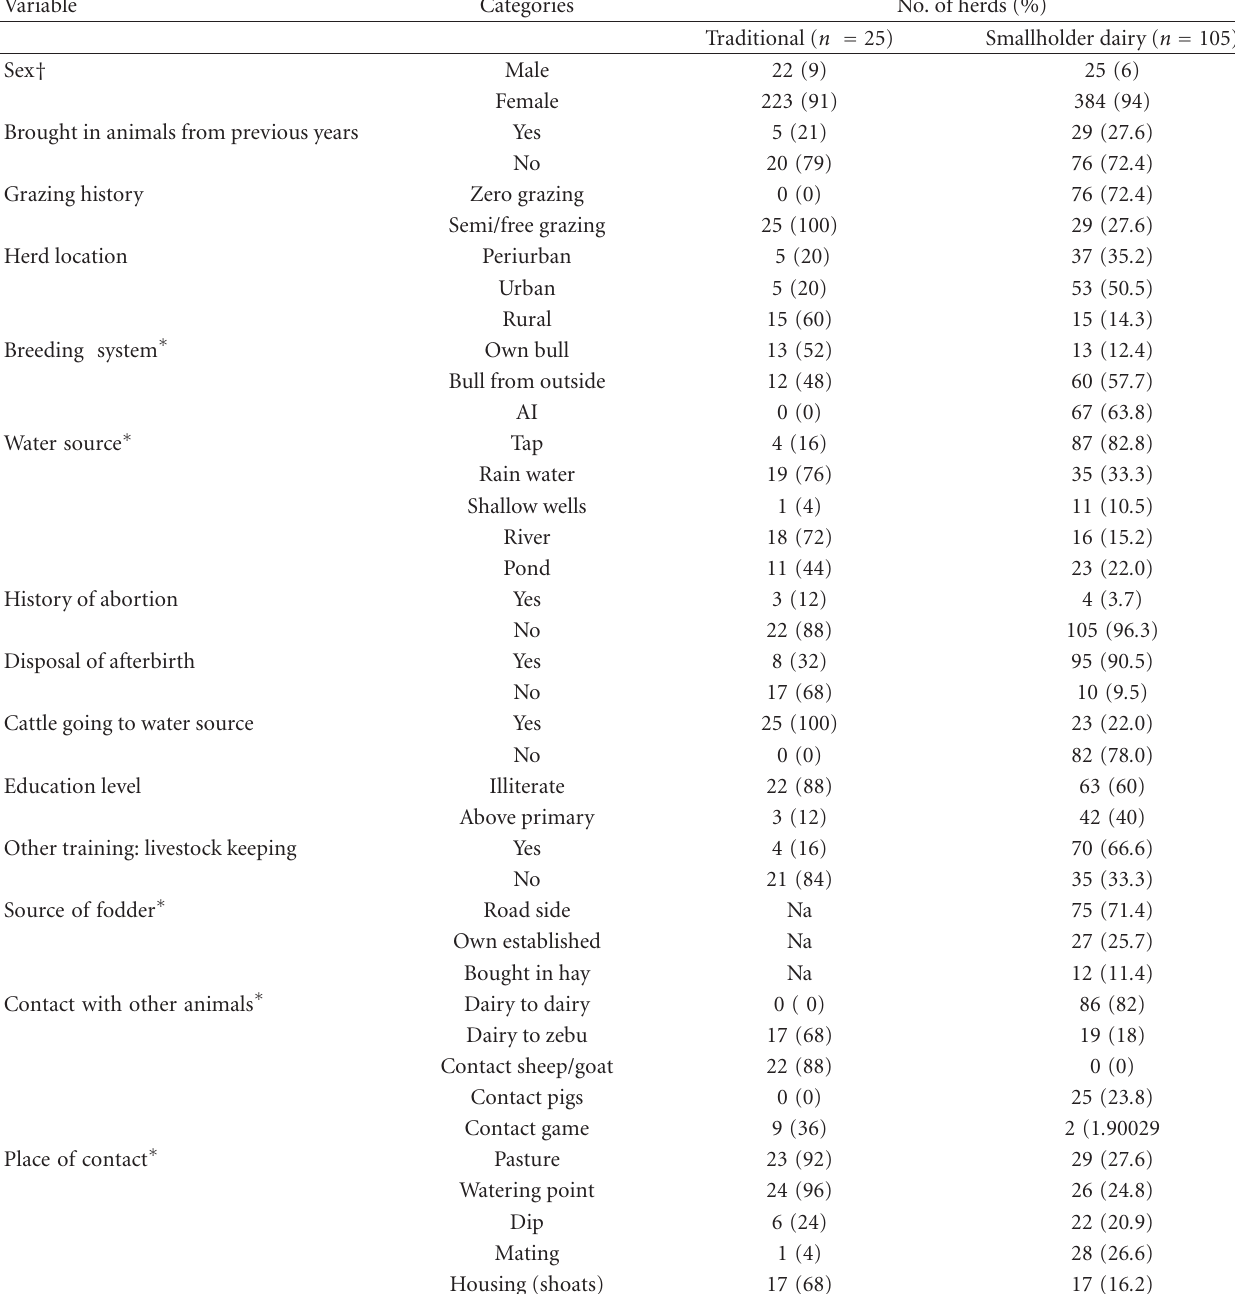
Table 1: The proportions of herd in each category of each variable investigated during the study (May 2003 − January 2004).